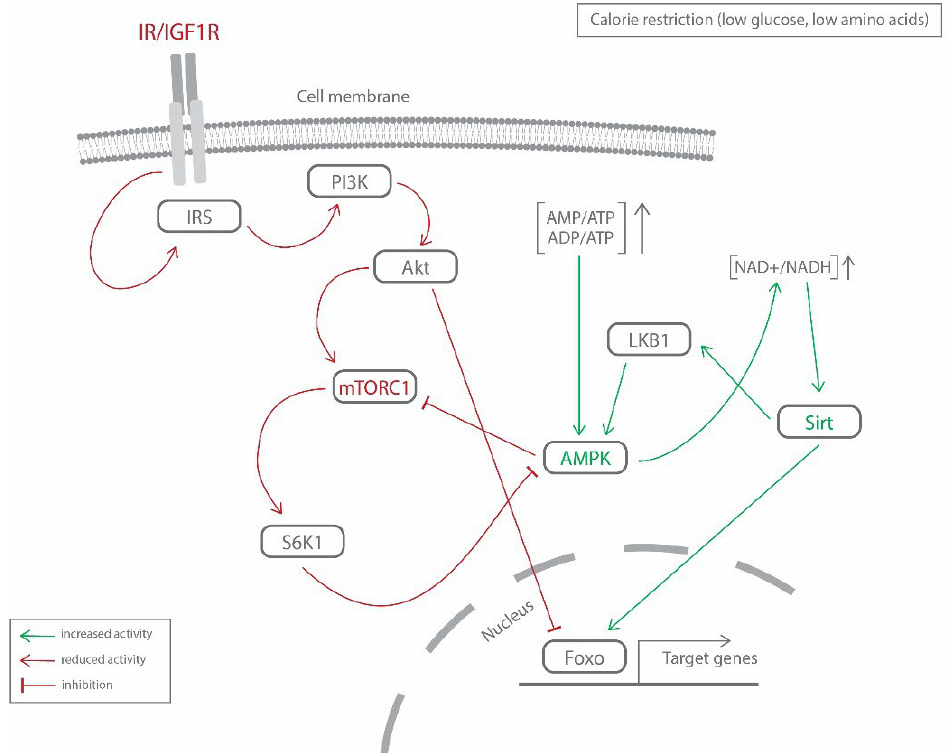
Figure 1. The interplay of the major nutrient-sensing pathways (IR/IGF1, mTORC1, AMPK, sirtuins) underlying CR’s pro-longevity effects. This figure represents a simplified version of the interconnectivity between the main molecular mechanisms and their components addressed in this review. IR/IGF1R—insulin/insulin-like growth factor 1 receptor; IRS—insulin receptor substrate; PI3K—phosphoinositide 3-kinase; Akt—protein kinase B; mTORC1—mammalian target of rapamycin complex 1; S6K1—S6 kinase 1; AMPK—AMP-activated protein kinase; LKB1—liver kinase B1; Sirt—sirtuins; Foxo—forkhead box protein O.